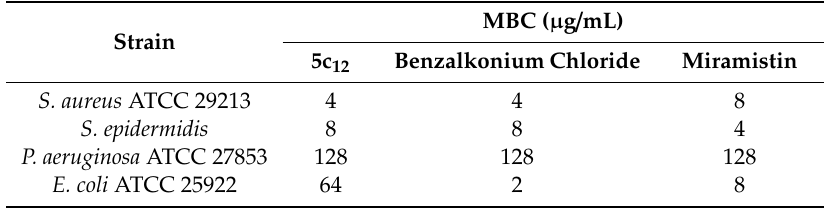
Table 6. Bactericidal activity of compound 5c 12 , benzalkonium chloride, and